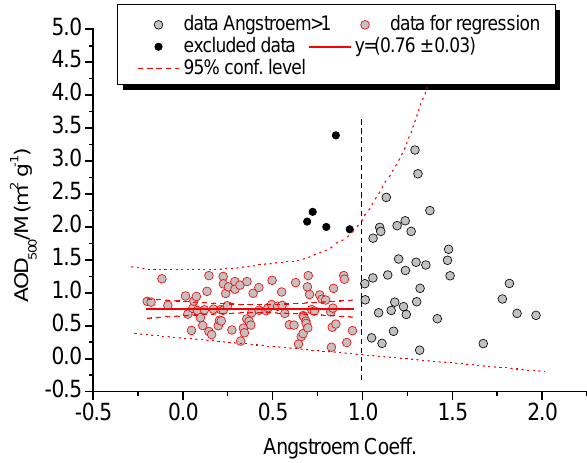
Figure 1. The ratio of AOD at 500 nm from measurements by the MFR-7 radiometer in Athens to dust loading derived by the BSC-DREAM model as a function of the Ångström exponent. The thick red line is the regression line for a fixed slope equal to 1 and for Ång- ström exponents lower than 1, and the dashed lines represent the standard error at the 95% confidence level. The dotted red lines illustrate in a free hand format the larger scatter for in- creasing Ångström exponents.